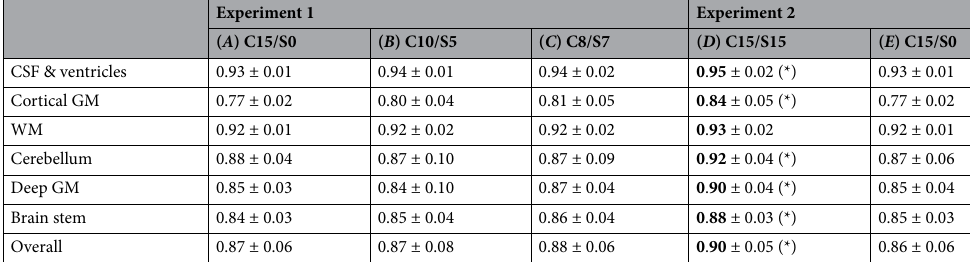
Table 6. DSC (mean ± SD) in the different configurations studied for all segmented brain tissues: cerebrospinal fluid (CSF) and ventricles, cortical gray matter (GM), white matter (WM), cerebellum, deep gray matter and brain stem, and on average. The number of clinical cases (Cxx) and the number of simulated subjects (Sxx) are recalled. We also emphasize that augmentation is performed twice more in configuration ( E ) compared to other configurations. The segmentation algorithm performs better (score in bold) in every structure when complementing the baseline dataset (configuration ( A )) with simulated subjects (configuration ( D )) than when performing standard data augmentation (configuration ( E )). P -values of Wilcoxon rank sum test between both data augmentation strategies (configurations ( D ) and ( E )) for individual fetal brain tissue segmentation are adjusted for multiple comparisons using Bonferroni correction. P < 0.05 (*) is considered statistically significant.